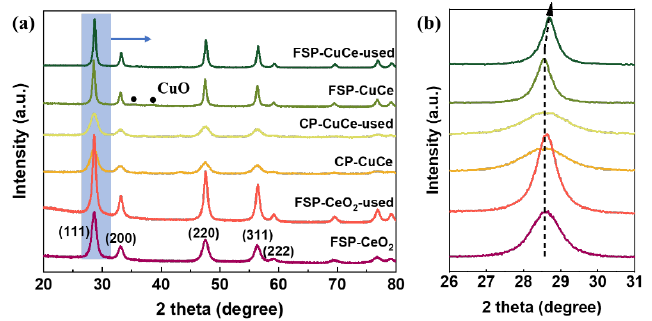
Figure 3. Lattice structure evaluation: ( a ) XRD patterns of fresh and used samples, including FSP- CeO 2 , FSP-CuCe(10) and CP-CuCe(10) catalysts; ( b ) the magnification of marked area.